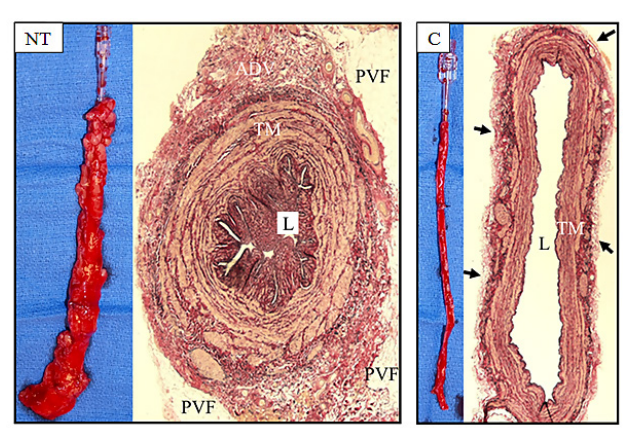
Fig. 2 – Examples of no-touch (NT) and conventional (C) saphenous vein (SV) grafts. The left panels show representative SV explants using both harvesting techniques. NT SV has its surrounding cushion of fat intact and has not been distended. C SV has the fat removed and has been distended to overcome spasm. The transverse section of NT SV shows an intact surrounding cushion of perivascular fat (PVF), an undamaged adventitia (ADV) and thick media (TM). As this vessel has not been distended, the lumen (L) is thrown into folds. The section of C SV exhibits various forms of damage. Much of the ADV has been stripped off, almost to the level of the external elastic lamina (small arrows). The media is thinner than that of the NT SV and L is grossly dilated, both due to high pressure intraluminal distension (Kopjar et al., 2016) [22]